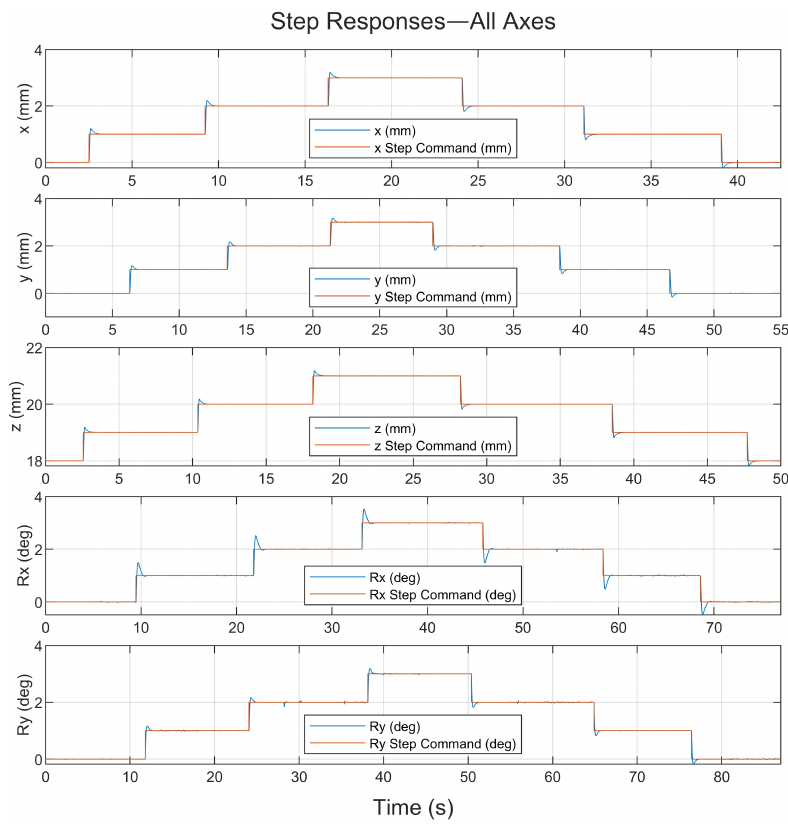
Figure 13. All axes step